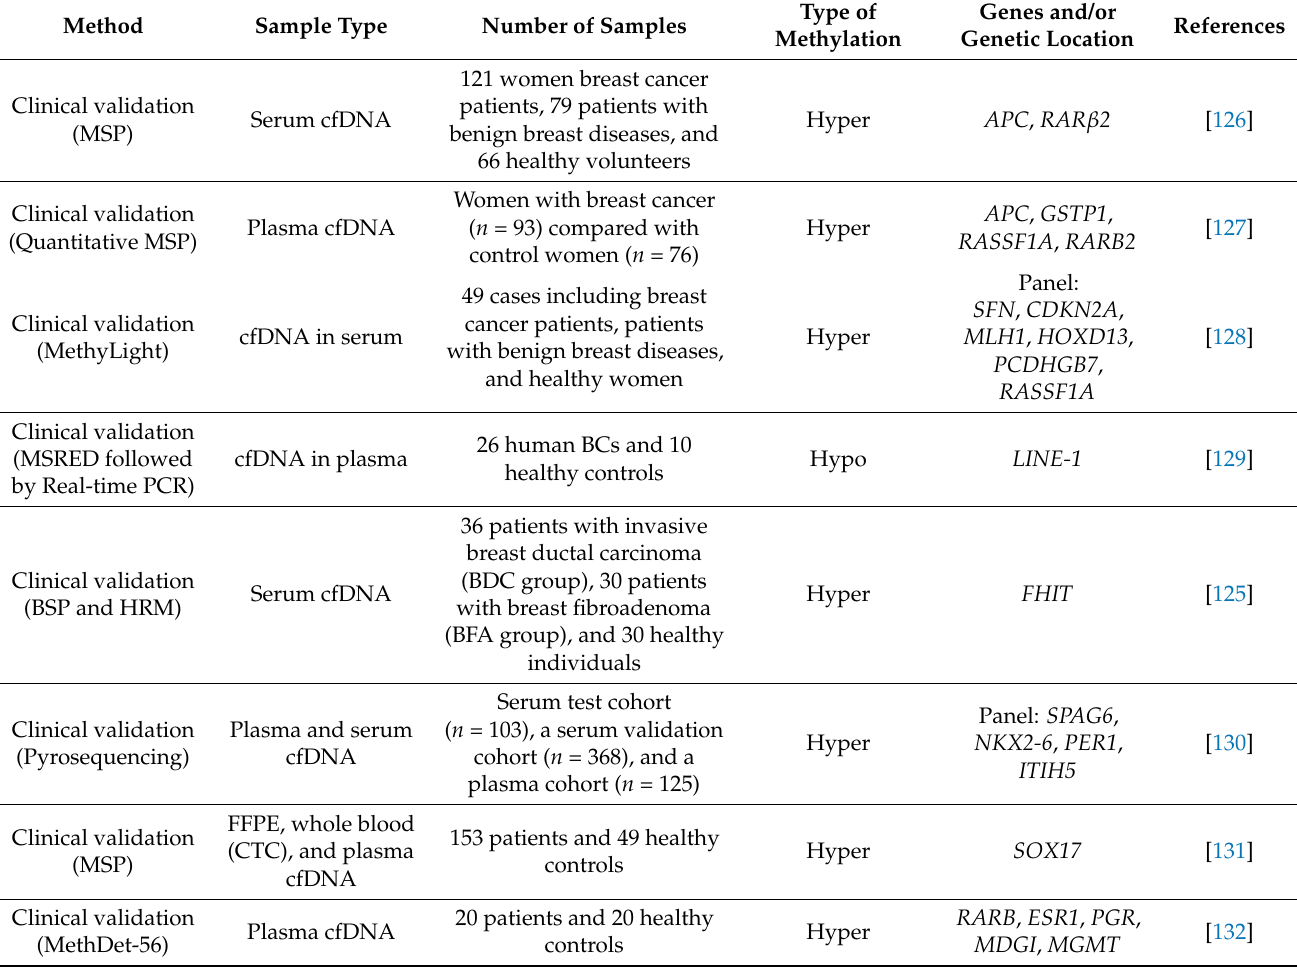
Table 7. An overview of methylation biomarkers for breast cancer in liquid biopsy. cfDNA: